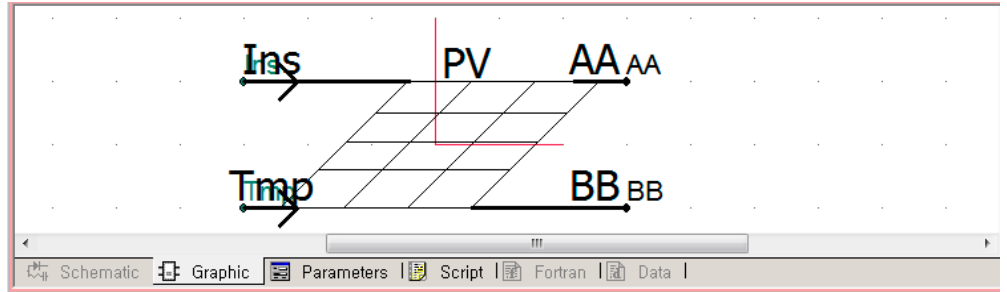
Figure 2. The component of the PV array model.